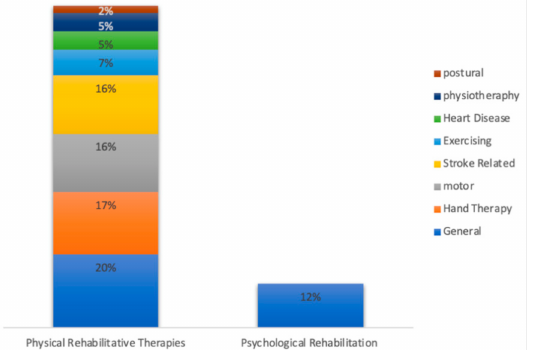
Figure 2. Article distribution based on the most gamification applications used in rehabilitation